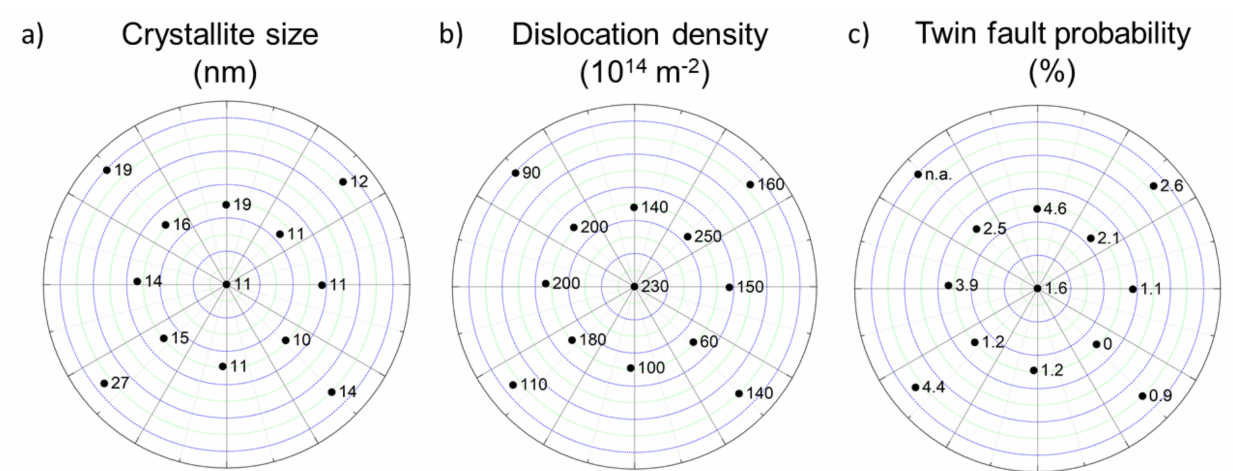
Figure 6. The crystallite size ( a ), the dislocation density ( b ), and the twin-fault probability ( c ) at different locations on the Co-Cr-Ni-Fe